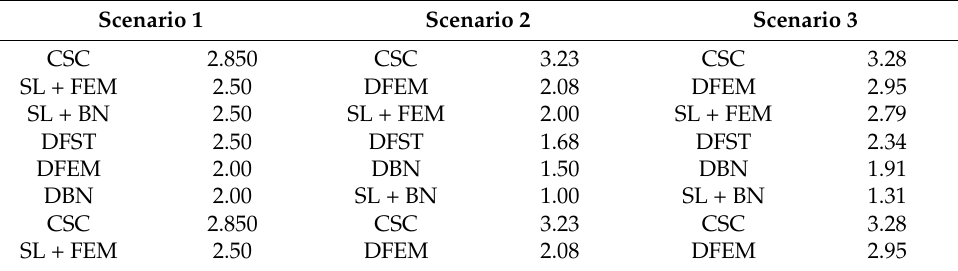
Table 3. Results of three scenarios by THOR 2